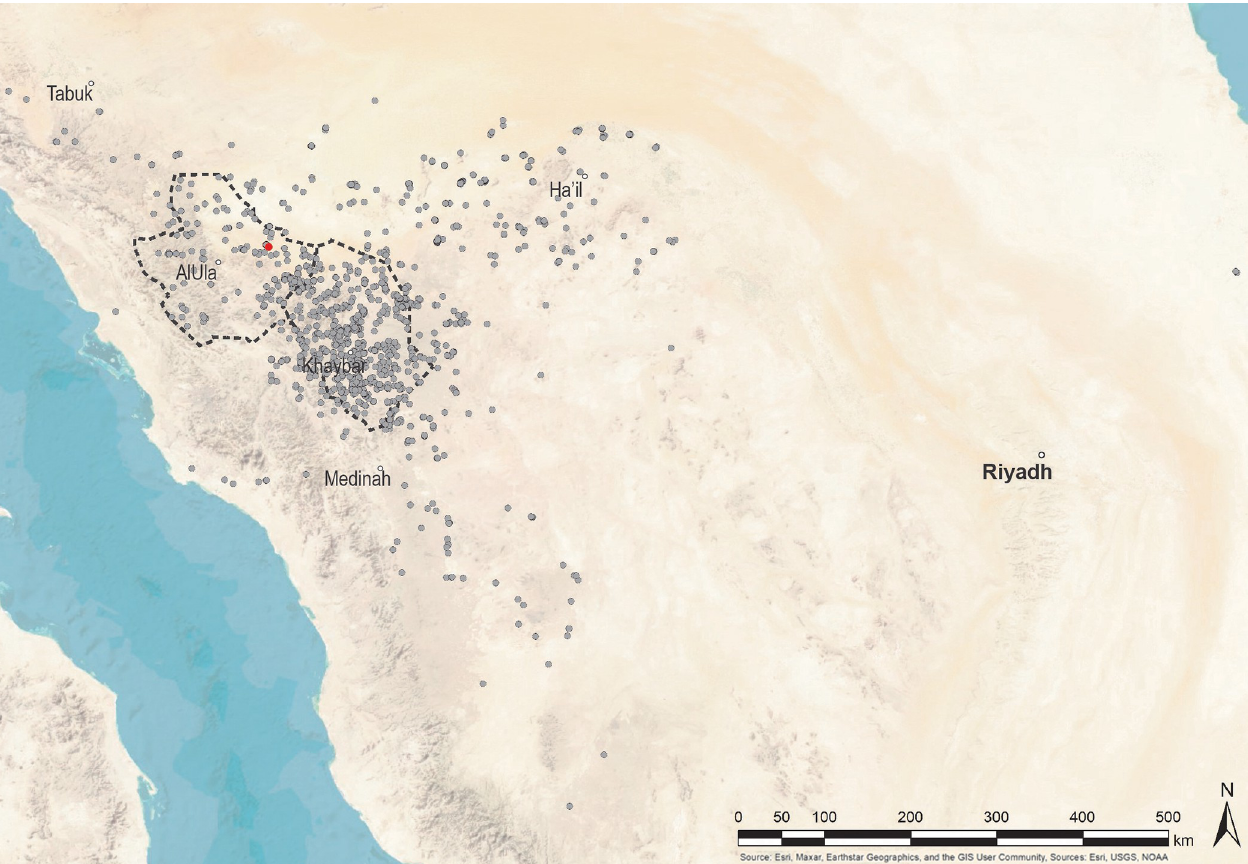
Fig 1. Mustatil locations in Saudi Arabia, location of site IDIHA-0008222 marked in red. Source: Esri, Maxar, Earthstar Geographics, and the GIS User Community, Sources: Esri, USGS, NOAA.